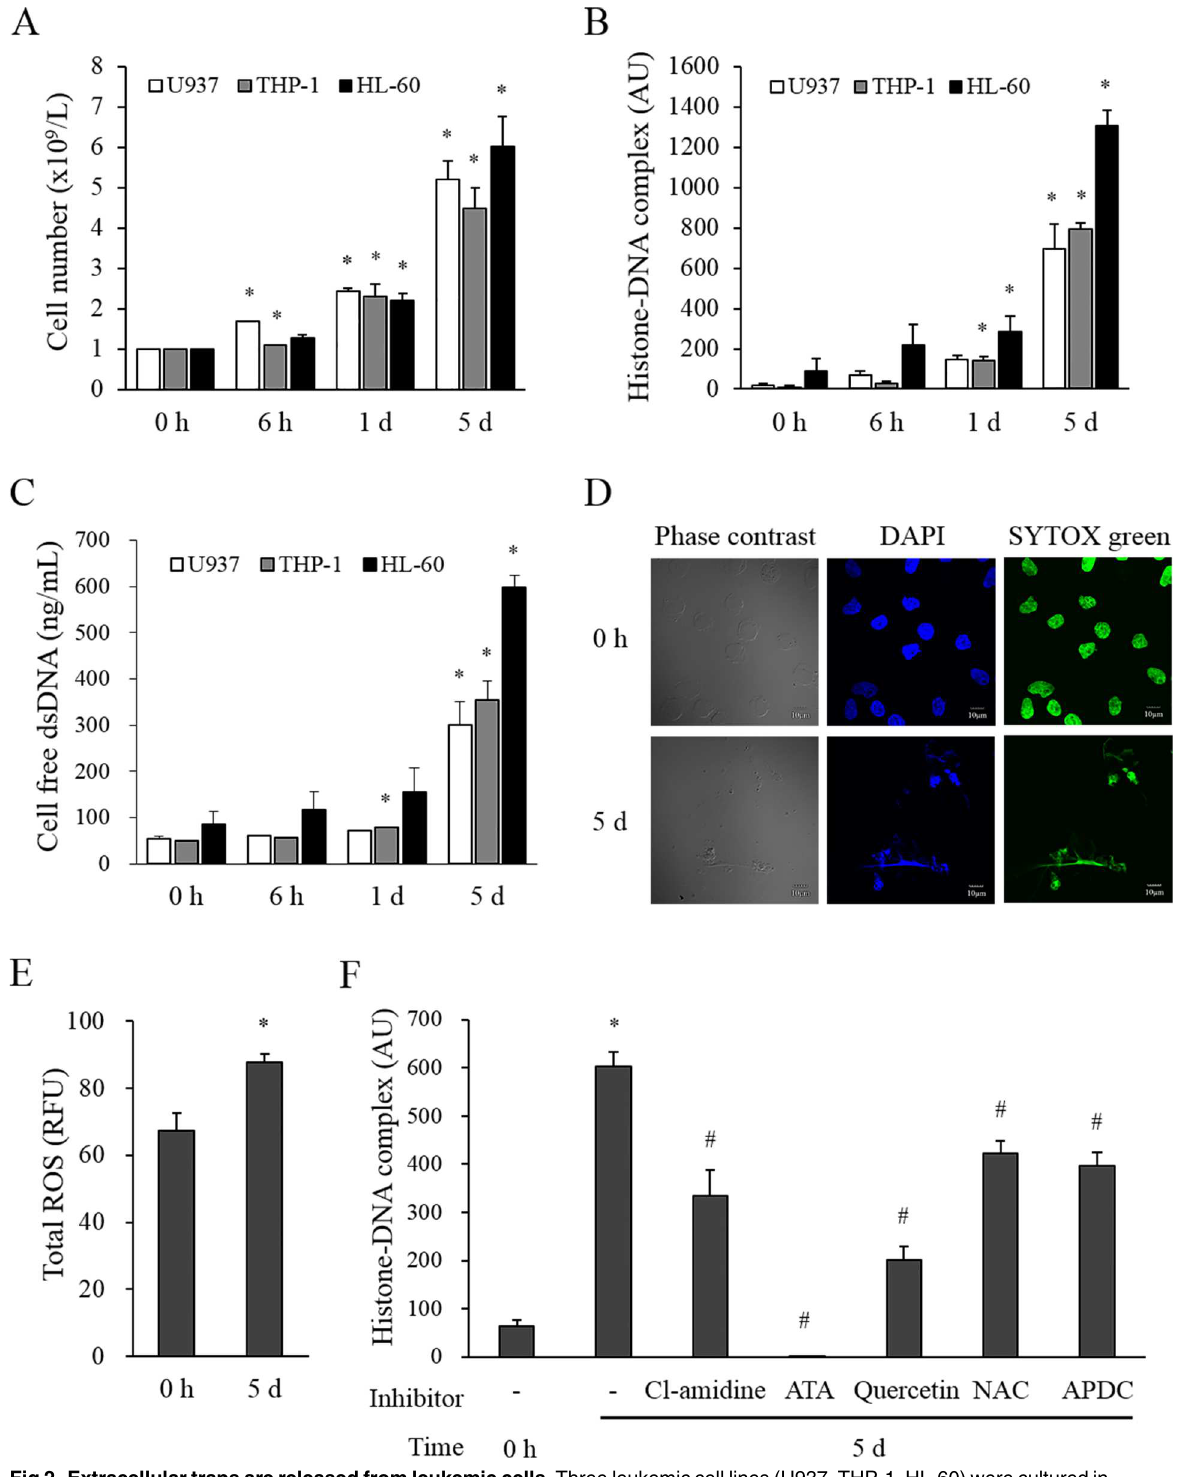
Fig 2. Extracellular traps are released from leukemic cells. Three leukemiccell lines (U937, THP-1, HL-60) were cultured in DMEM with 10% fetal calf serum without medium exchangefor 5 days. (A) The numbers of autonomously proliferatedcells are expressed as mean ± SEM of 4 experiments. (B, C) The levels of the histone–DNA complex and cell-free dsDNA were measured in the corresponding culture supernatants. (D) U937 cells (fresh or cultured for 5 days) were stained with SYTOX green and DAPI and observedusing a confocal laser microscope.Images shown are representative of 3 independent experiments. (E) Total ROS activity